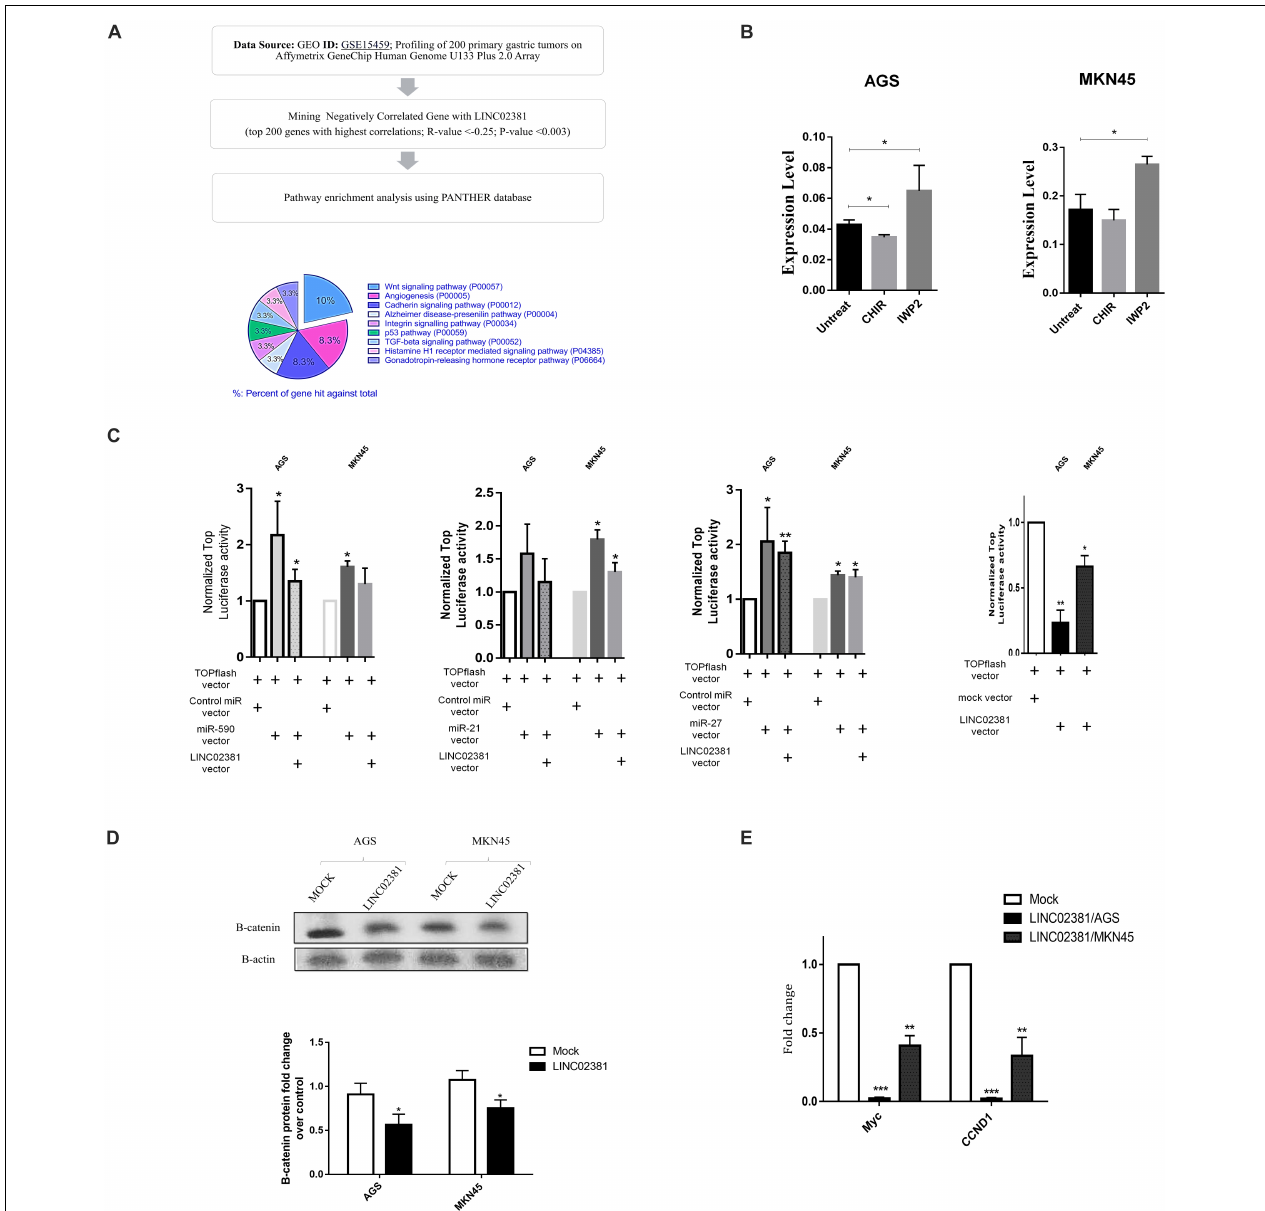
FIGURE 4 | Association of LINC02381 and related miRNAs expression with Wnt signaling. (A) Shows the pathway enrichment analysis flowchart using PANTHER database. (B) Shows quantitative LINC02381 gene expression analysis following the treatment of both cell lines with the Wnt signaling inhibitor (IWP2) and Wnt activator (CHIR) small molecules. Results indicated that LINC02381 is negatively regulated by Wnt signaling. Data represent the mean ± SEM from three independent experiments. * P < 0.05. (C) AGS and MKN45 cells were co-transfected using TOPflash along with either control, miR-590, miR-21, miR-27a, or LINC02381 expressing vectors. TOPflash luciferase activity indicated that overexpression of miR-590 and miR-27a was followed by significantly increased Wnt activity in both cell lines while LINC02381 overexpression resulted in significant reduction of Wnt activity. Data represent the mean ± SEM from three independent experiments. * P < 0.05, ** P < 0.01. (D) Western blot assays confirmed that B-catenin expression were downregulated in AGS and MKN45 cells by overexpression of LINC02381. Data represent the mean ± SEM. * P < 0.05. (E) RT-qPCR results also showed that overexpression of LINC02381 in both cell lines, was followed by reduced c-MYC and CCND1 expression, as the downstream genes to Wnt signaling pathway. Data represent the mean ± SEM from three independent experiments. * P < 0.05, ** P < 0.01, *** P <